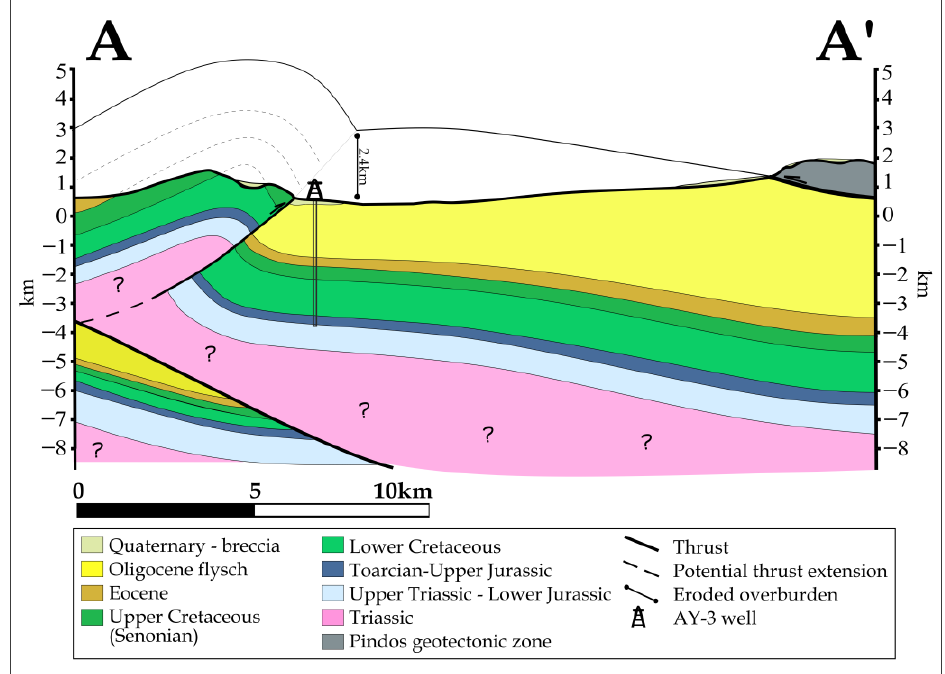
Figure 9. Simplified cross section showing the interpreted paleo-shape of the AY-3 area, of the Internal Ionian thrust, in pre-erosion Miocene times. The mean pre-erosion overburden thickness of the AY-3 well location is 2.4 km and it is estimated by thermal maturity modeling.